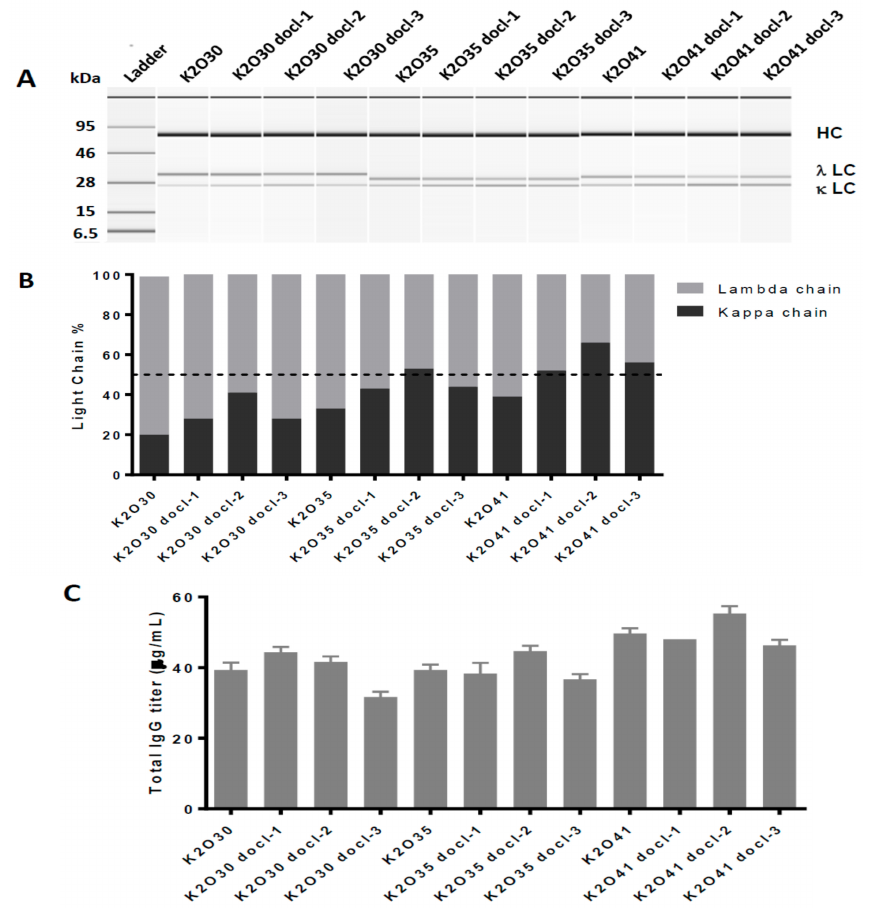
Figure 1. IgG expression of K2O30, K2O35, K2O41 and their respective codon de-optimized variants after transfection in Transformed Human Embryo Kidney monolayer epithelial cells (PEAK cells). ( A ) Electrophoresis using the Agilent Bioanalyzer 2100 for total IgG obtained after the first affinity chromatography step capturing all three IgG forms. The bands corresponding to the common heavy chain (HC), the lambda light chain ( λ LC) and the kappa light chain ( κ LC) in reducing and denaturing conditions are indicated. ( B ) Ratio of the light chains as determined from the band intensity of the Agilent result. ( C ) Total IgG concentration in the culture